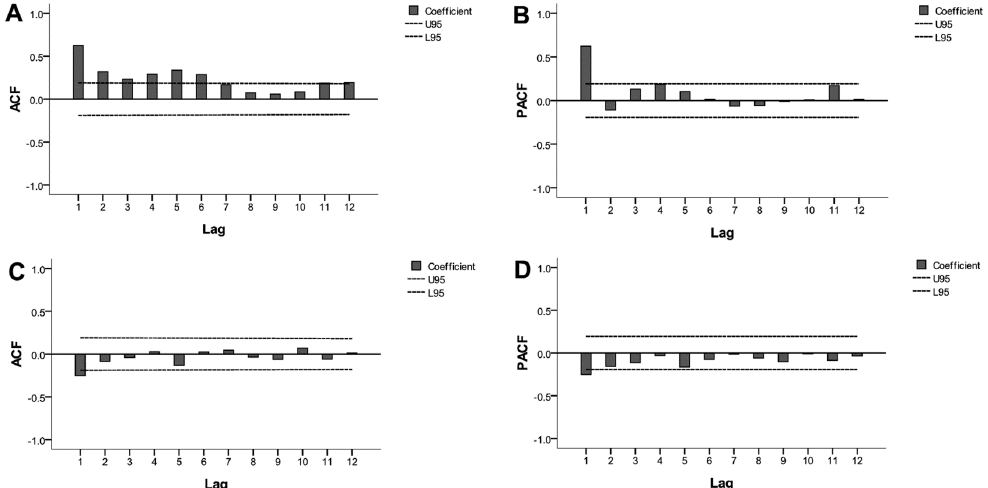
BIC, bayesian information criterion. RMSE, root mean square error; MAE, mean absolute error; MAPE, mean absolute percentage error;